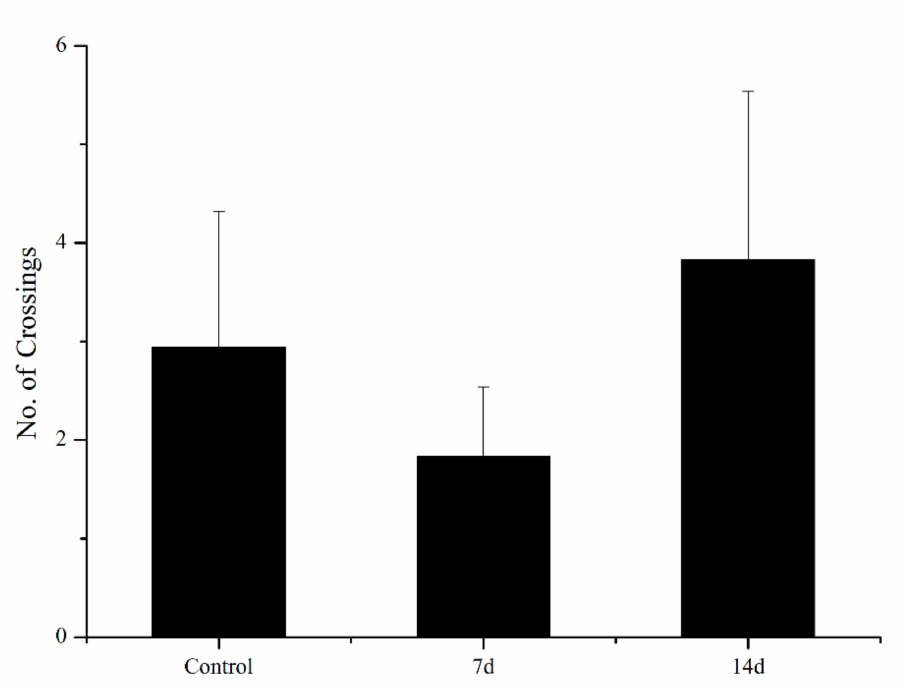
Figure 7. Effects of 7 and 14 days of UCS protocol on several crossing the center in the rare minnow. Data are expressed as mean ± SE (n = 15–18).